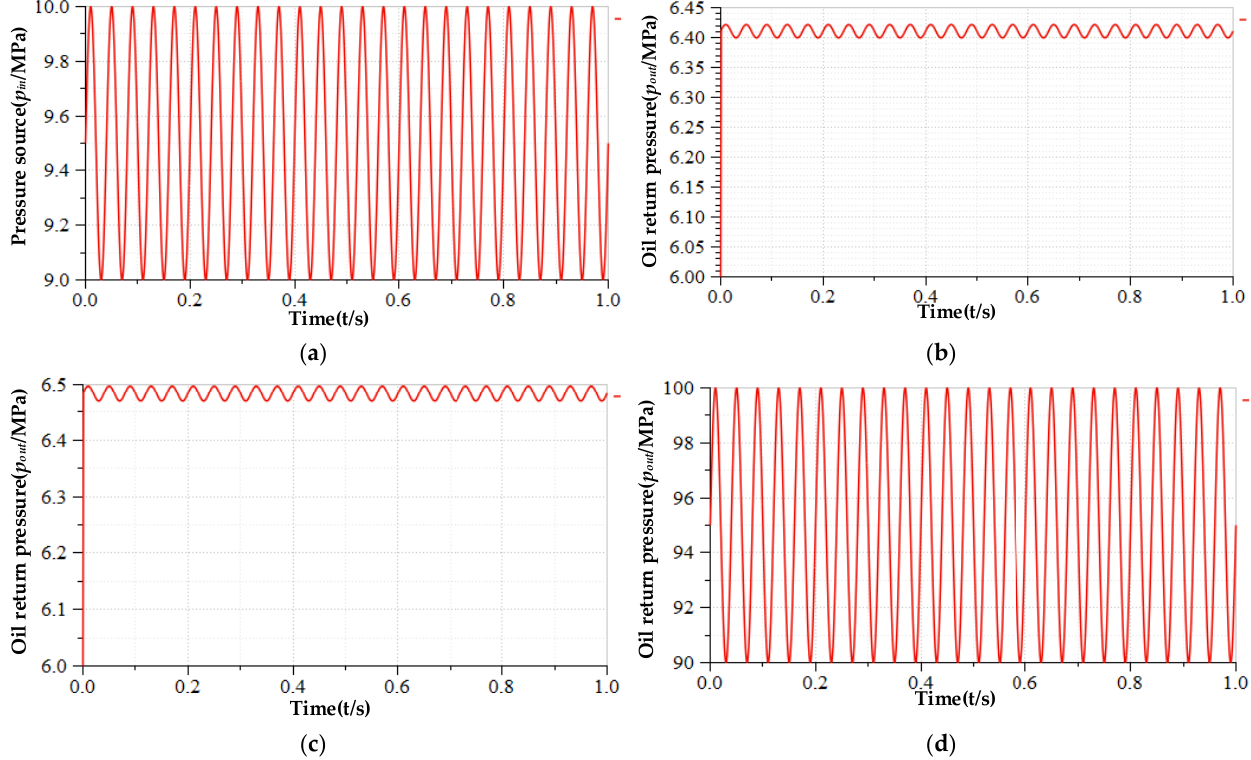
Figure 17. Pressure in the hose under the action of the sinusoidal pressure source: ( a ) pressure source; ( b ) pressure in hose (after thin-walled orifice); ( c ) pressure in hose (after thick-walled orifice); ( d ) pressure in hose (without orifice).